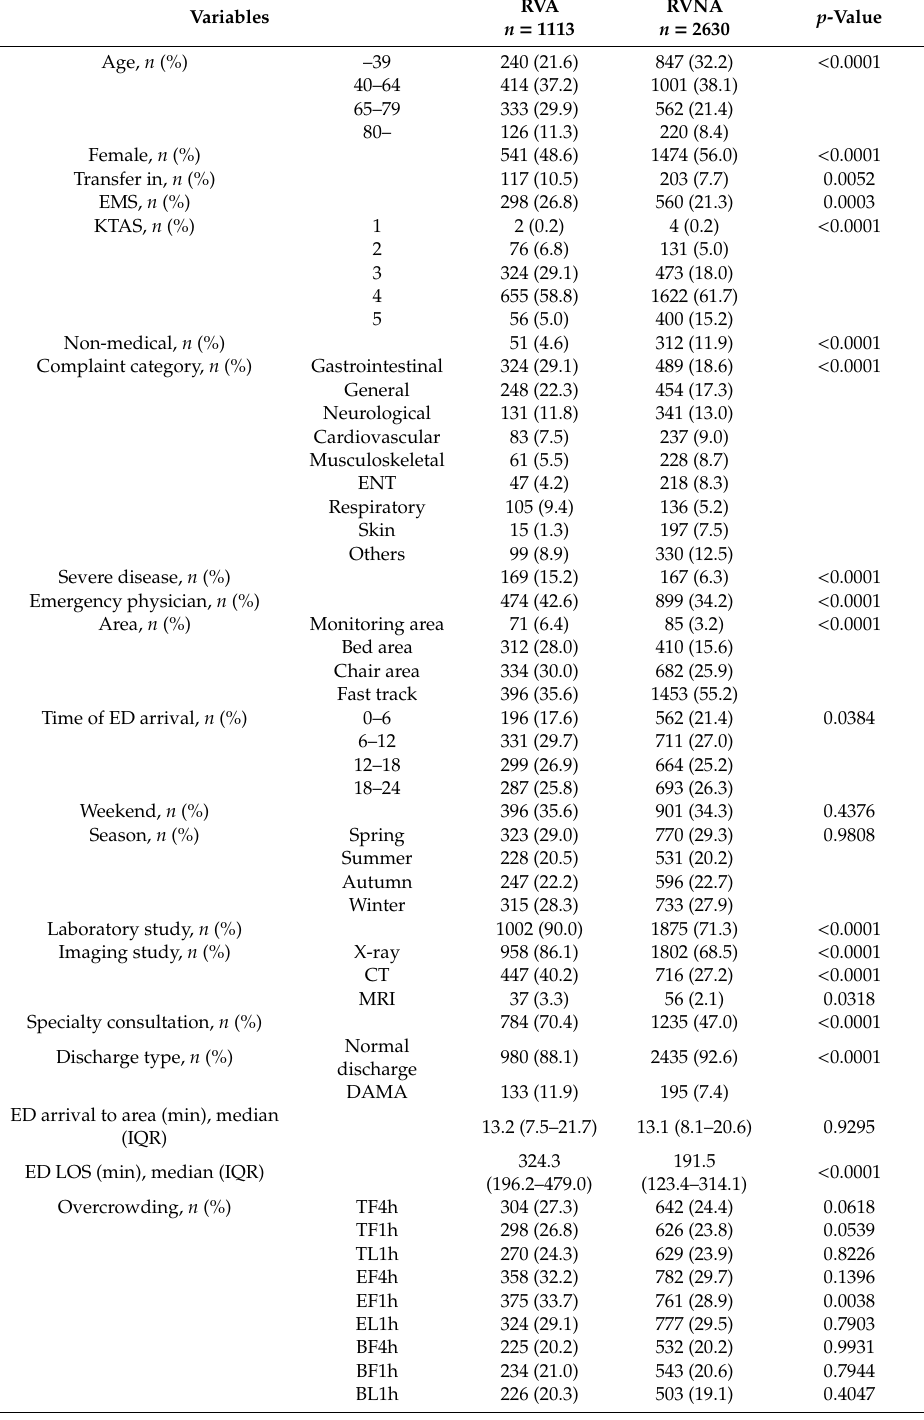
Table 2. Comparison of patient characteristics of index visits according to the treatment result of return